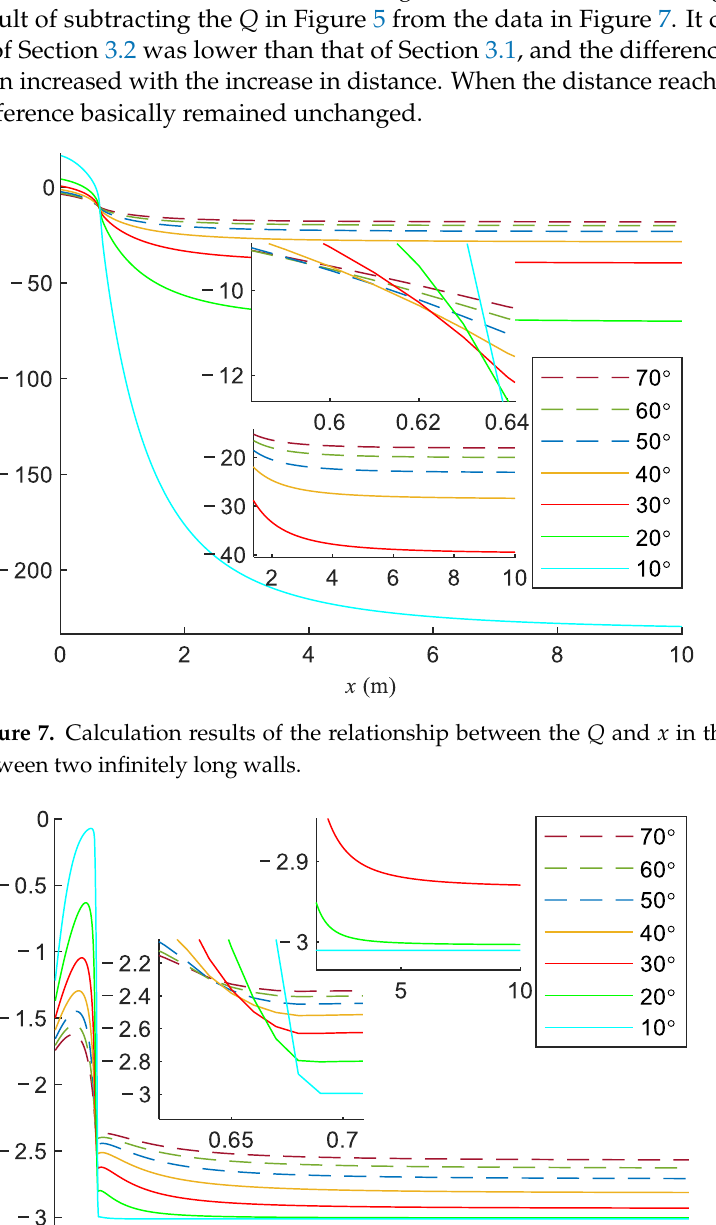
Figure 6. Schematic diagram of the calculation analysis of a corner between two infinitely long walls.